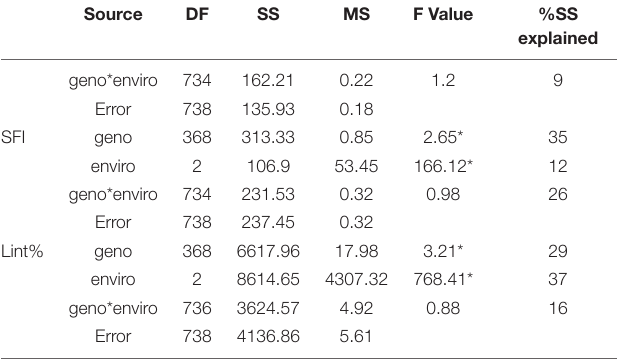
TABLE 5 | Analysis of variance components for fiber quality traits in crosses between mutant and elite